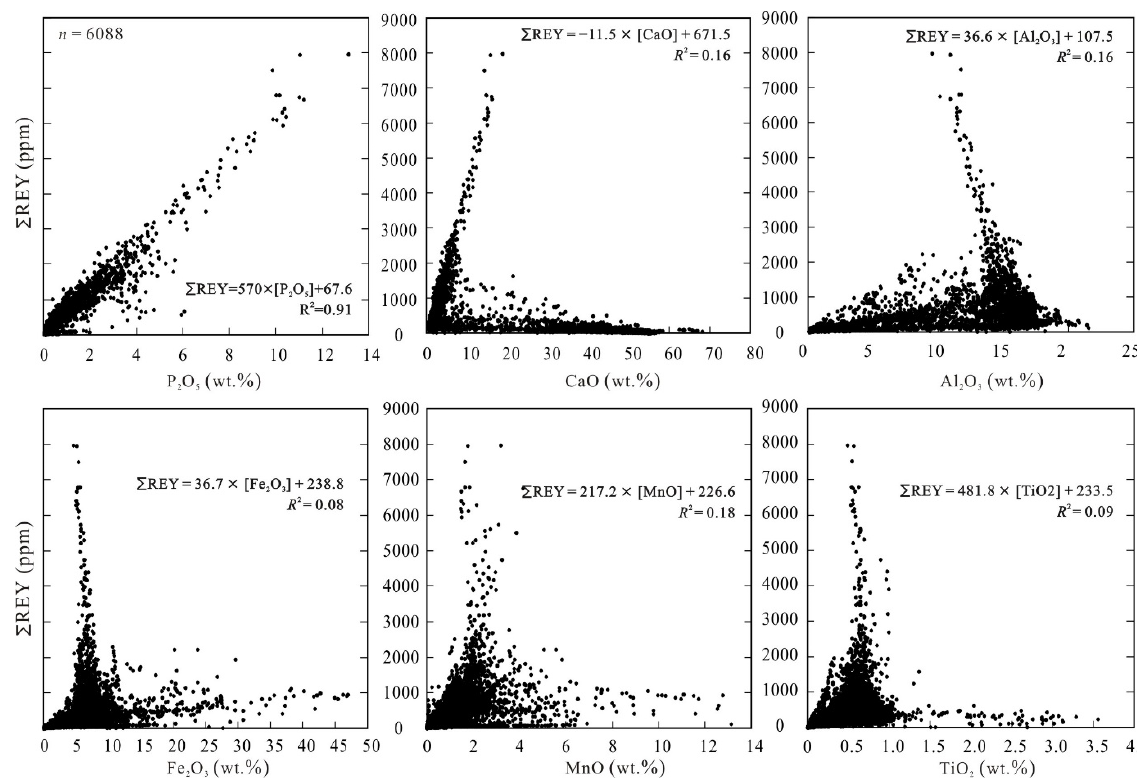
Figure 3. Correlations between Σ REY and major oxides in deep ‐ sea sediments; data sources as in Figure 1.